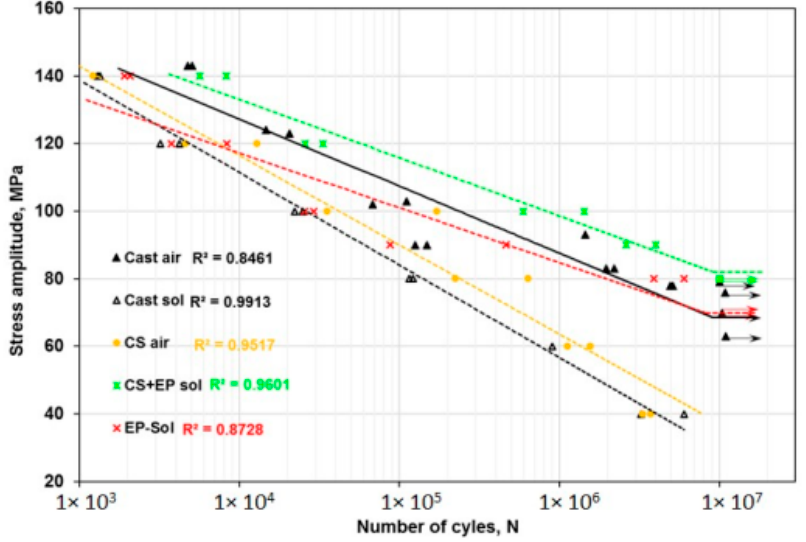
Figure 9. Effects of coating process on the corrosion resistance of AZ31 magnesium alloy [75].